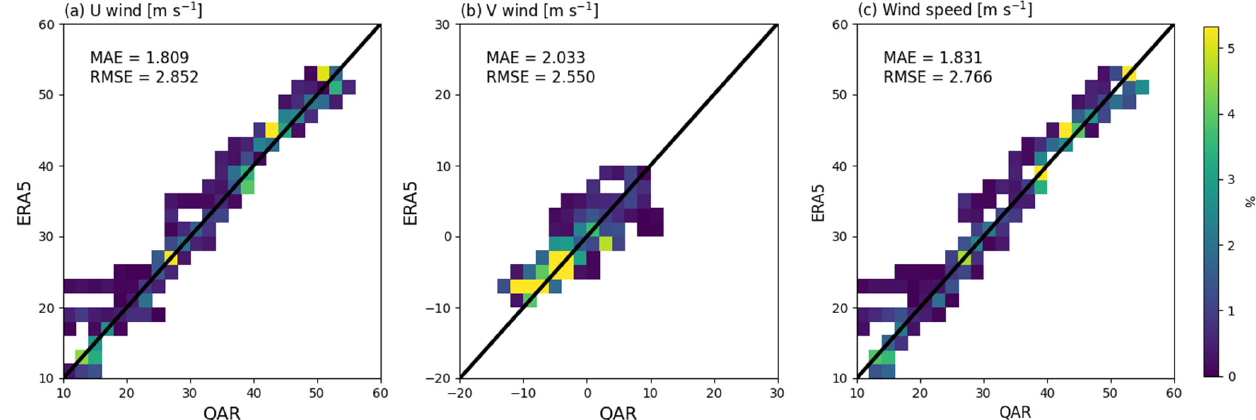
Figure 3. The scatter density plots of correlation for ( a ) u-, ( b ) v-wind components, and ( c ) wind speed between the quick access recorder (QAR) data and the fifth generation of the European Centre for Medium-range Weather Forecast reanalysis (ERA5) data during the research period from 05:40 UTC to 06:30 UTC on 28 October 2018. Color scales are probability of occurrence (%), and the black diagonal lines are the perfect correlation. Mean absolute error (MAE) and root mean square error (RMSE) values are also depicted in each plot.